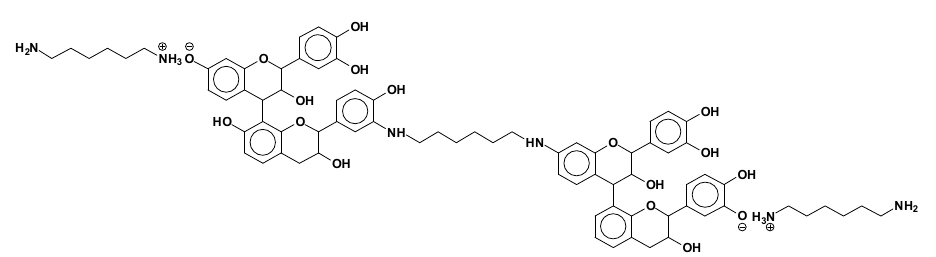
Figure 13. Example of flavonoid dimer and monomer covalently bridged by a diamine with other covalently linked diamines at 1169 Da.